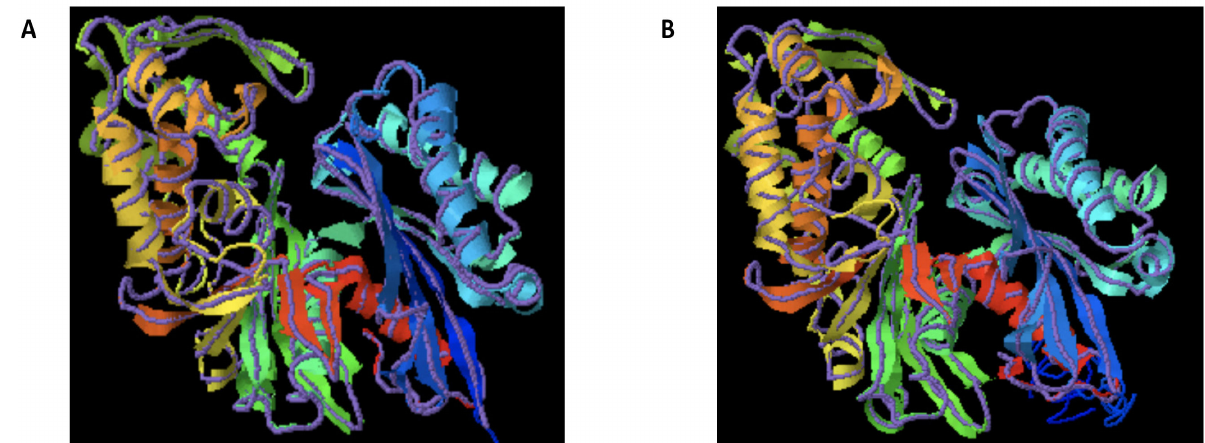
Figure 1. Models of selected plant APYs. Homology models of the potato ( A ) and pea PsNTP9 ( B ) apyrases are shown as ribbons colored with a rainbow spectrum. Both models are aligned with the crystal structure of the V. unguiculata APY crystal structure [41] show as a purple thread. Models and structural alignment were produced using the I-TASSER server